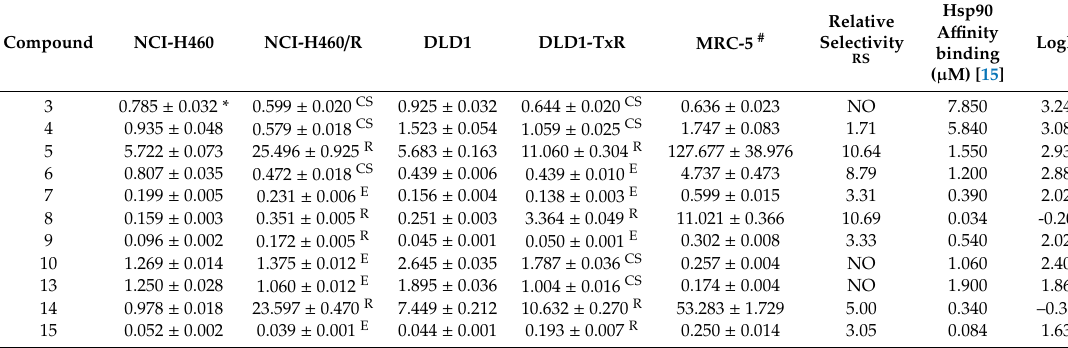
Table 1. Cell growth inhibition (presented as IC 50 values in μ M) induced by Hsp90 inhibitors with different affinity of binding to Hsp90.